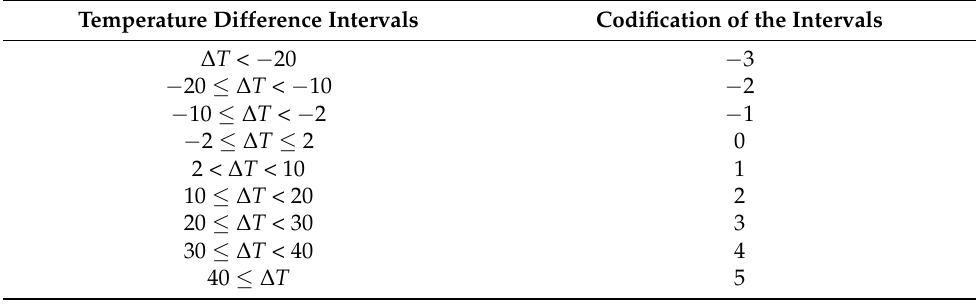
Table 3. Difference temperature